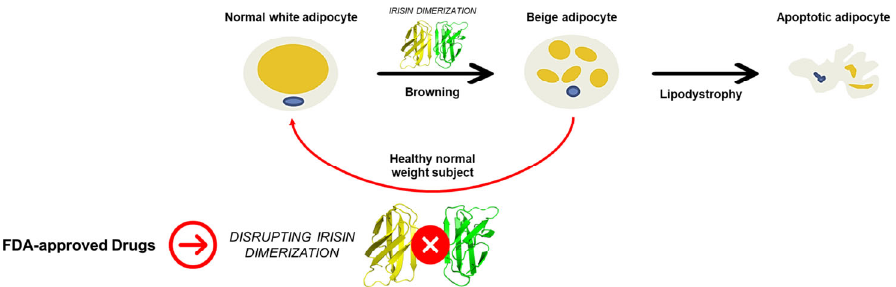
Figure 1. Schematic representation of the relevance of disrupting irisin dimerization in lipodystro- phy.